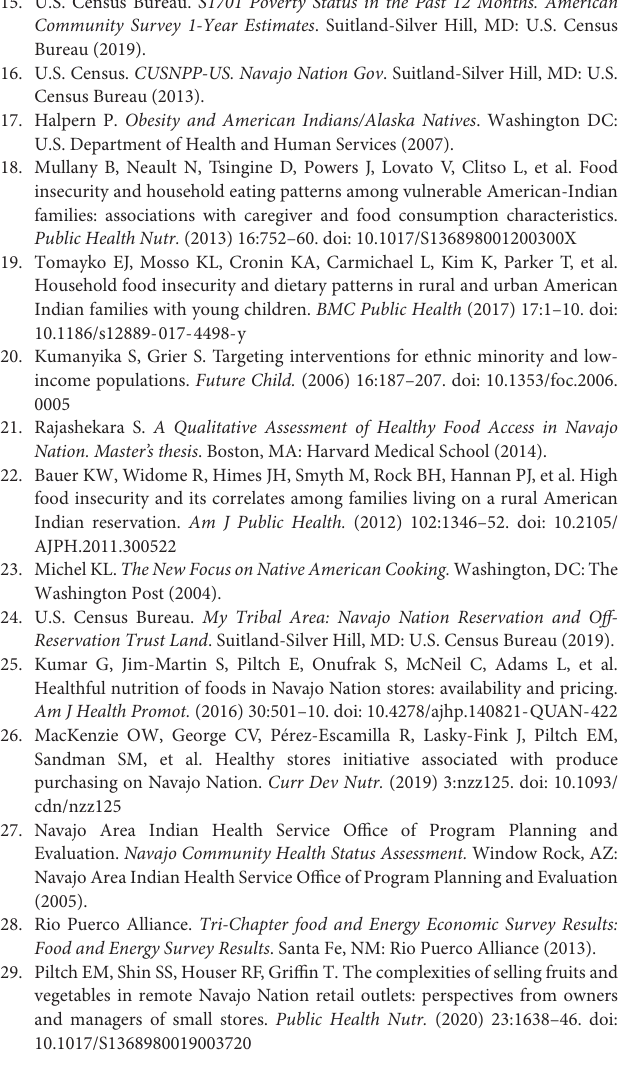
Supplementary Figure 1 | Driving distances by location on and off the Navajo reservation in minutes. (A) Grocery driving distances within the Navajo reservation. (B) Restaurant driving distances within the Navajo reservation. (C) Convenience driving distances within the Navajo reservation. (D) Grocery driving distances in border towns. (E) Restaurant driving distances in border towns. (F) Convenience driving distances in border